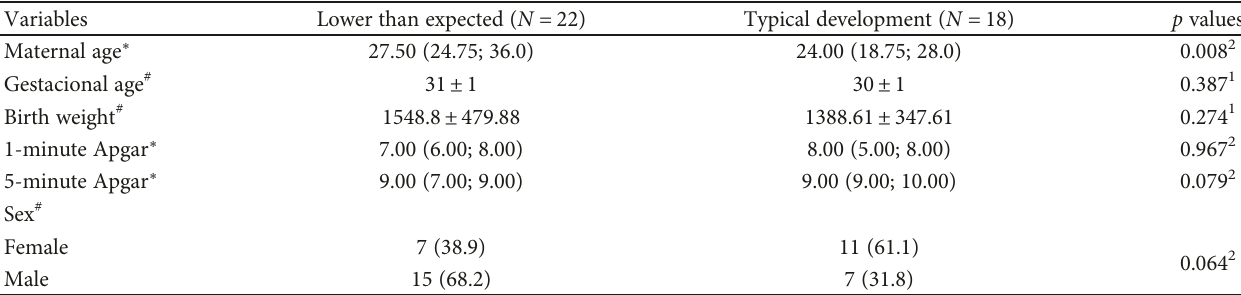
Table 3: Association between clinical features and motor development results in TIMP. Variables